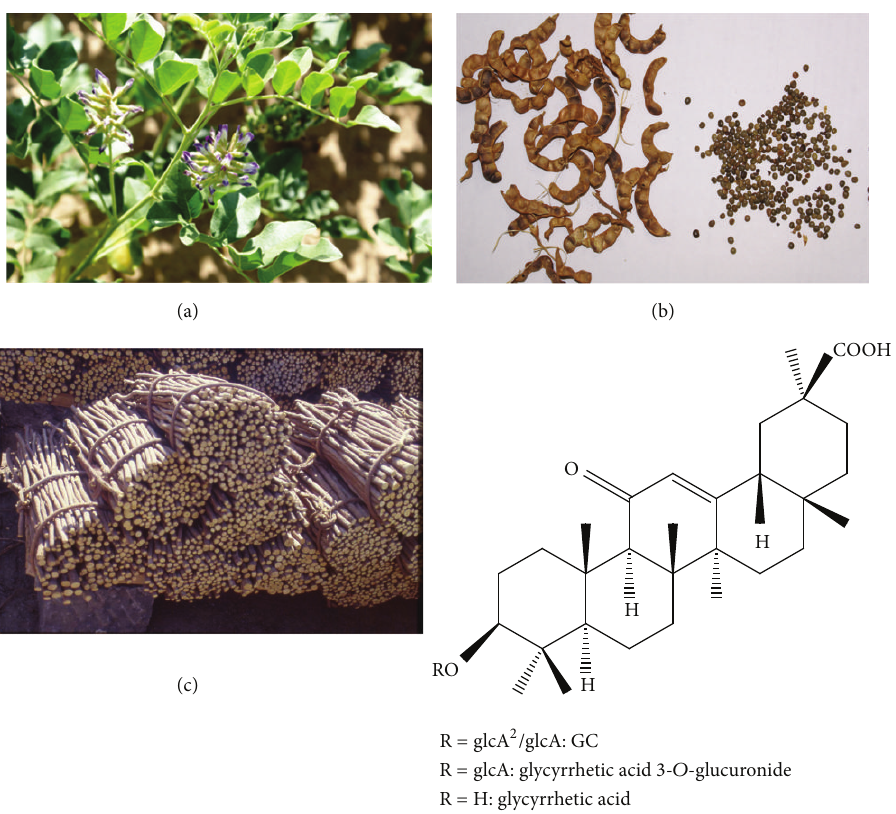
Figure 1: Glycyrrhiza uralensis Fischer and structures of glycyrrhizin and related compounds: (a) flowering, (b) fruits and seeds, and (c) licorice